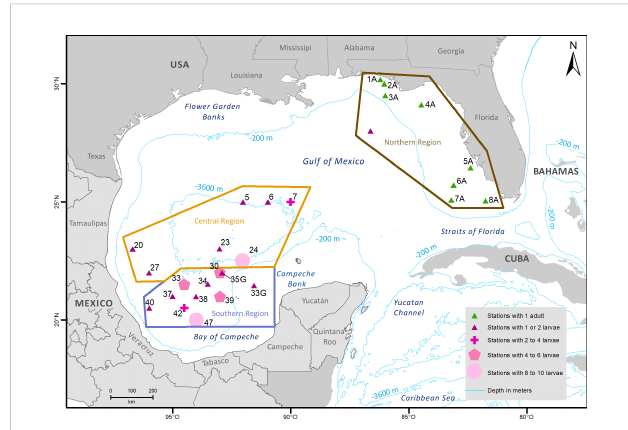
FIGURE 3 Distribution of Bothus robinsi larvae and adults, included in the fi nal library, separated in three regions: central, southern, and